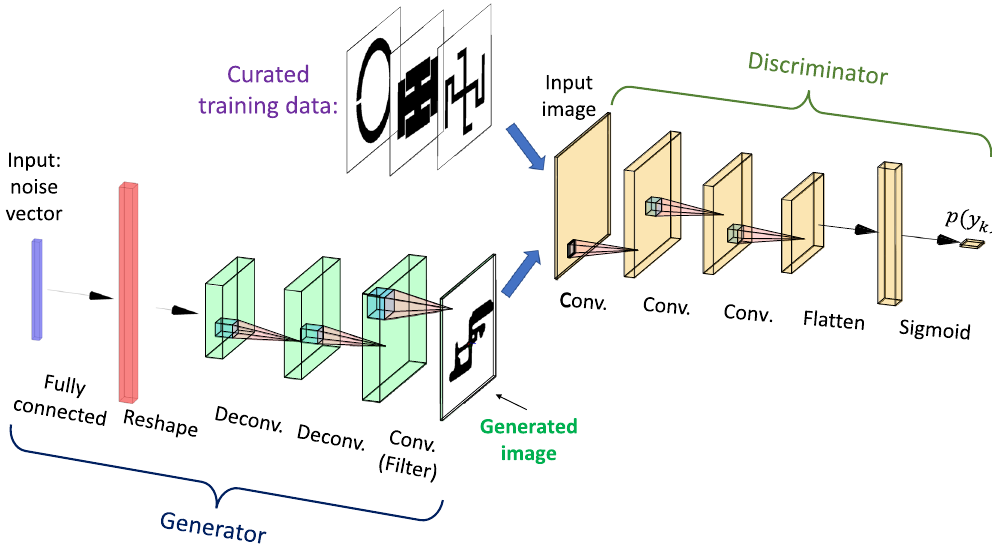
Figure 2. Representative architecture of the GAN including the generator and the discriminator .